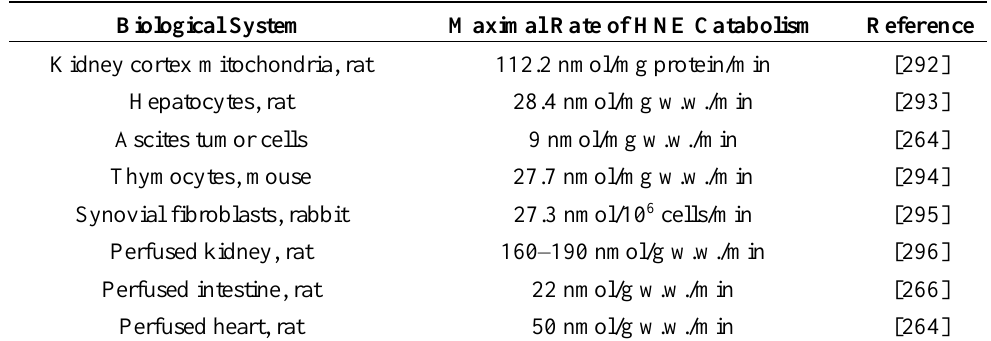
Table 2. Maximal velocity of total HNE degradation in cells, subcellular organelles, and perfused